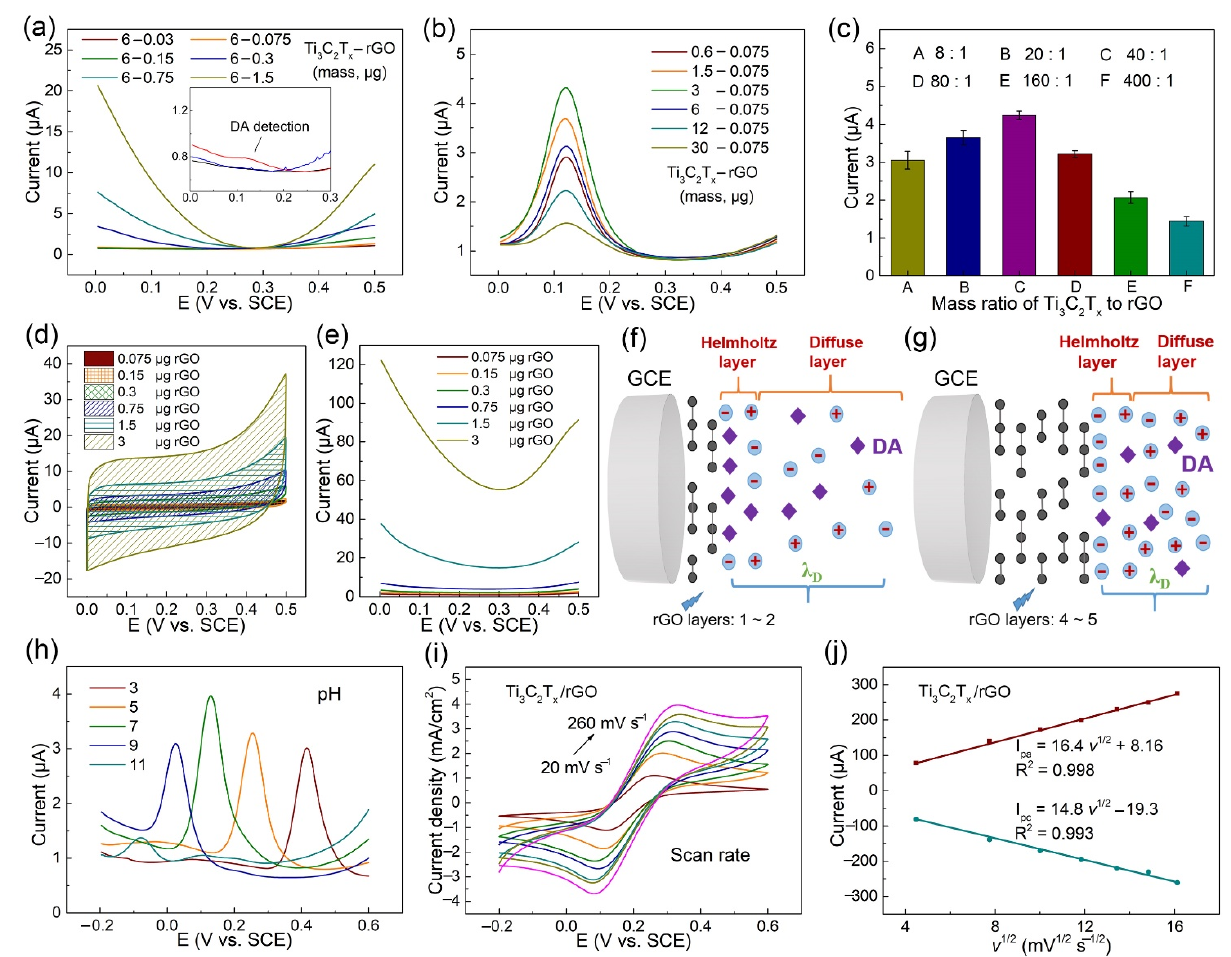
Figure 4. ( a ) DPV curves of Ti 3 C 2 T x /rGO electrode with various masses of rGO to the same of Ti 3 C 2 T x with 100 nM DA in PBS; the inset graphic depicts an enlarged view in the potential range between 0.0–0.3 V. ( b ) DPV of Ti 3 C 2 T x /rGO electrode with various masses of Ti 3 C 2 T x to the same of rGO with 10 μ M DA in PBS. ( c ) the corresponding current value of ( b ). ( d , e ) CV and DPV of rGO electrode in PBS with various amounts of rGO, respectively. ( f , g ) Schematic diagram of EDL model to interpret DA detection mechanism via Debye length regulation. ( h ) DPV of 10 μ M DA on Ti 3 C 2 T x /rGO electrode with pH. ( i ) Ti 3 C 2 T x /rGO electrode in 10 mM [Fe(CN) 6 ] 3 − /4 − and 0.1 M KCl electrolyte solution at scan rates ( v ) from 20 to 260 mV s − 1 . ( j ) Linear plots of I pa /I pc vs. v .